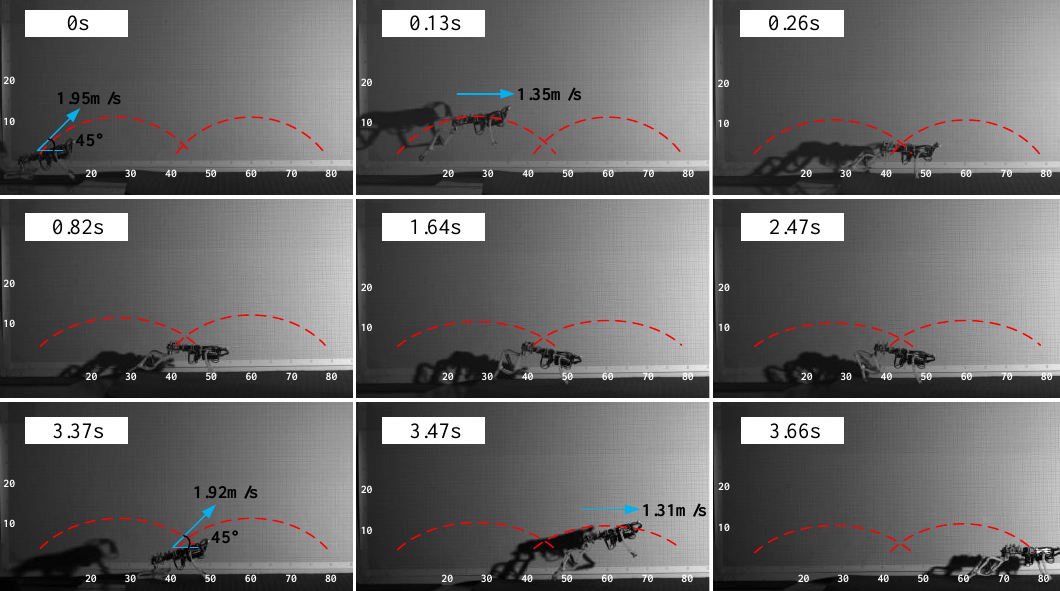
Figure 27. Motion sequence of jumping for progress. The dotted red lines denote jumping trajectory, and the blue arrows denote the direction of velocity.